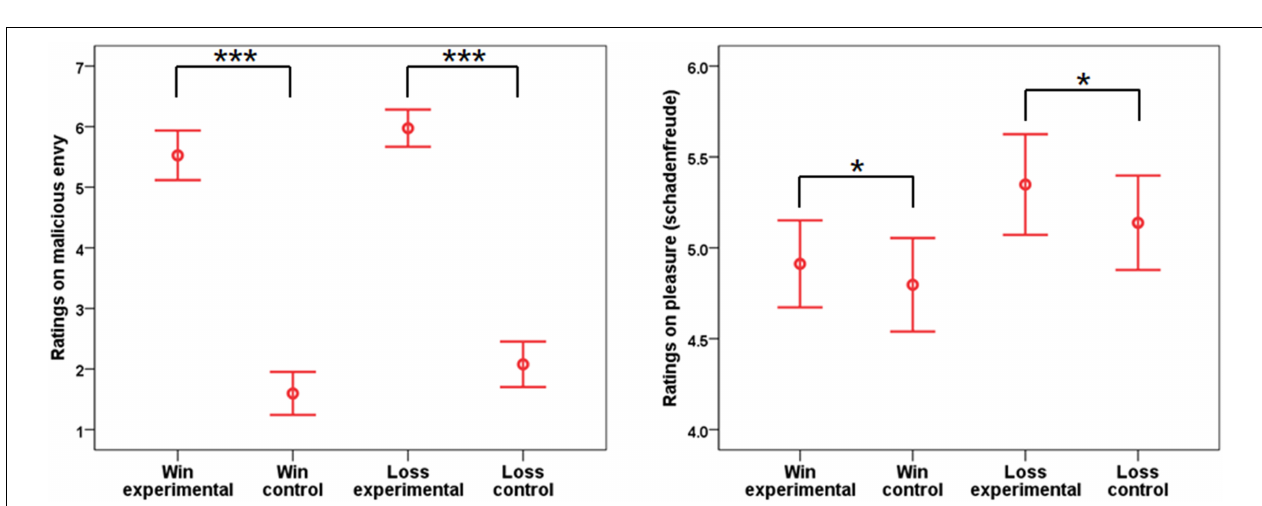
FIGURE 5 | Topographical maps based on the mean amplitude of feedback-related negativity (FRN) and early and late positive potentials (LPPs) for all experimental conditions.